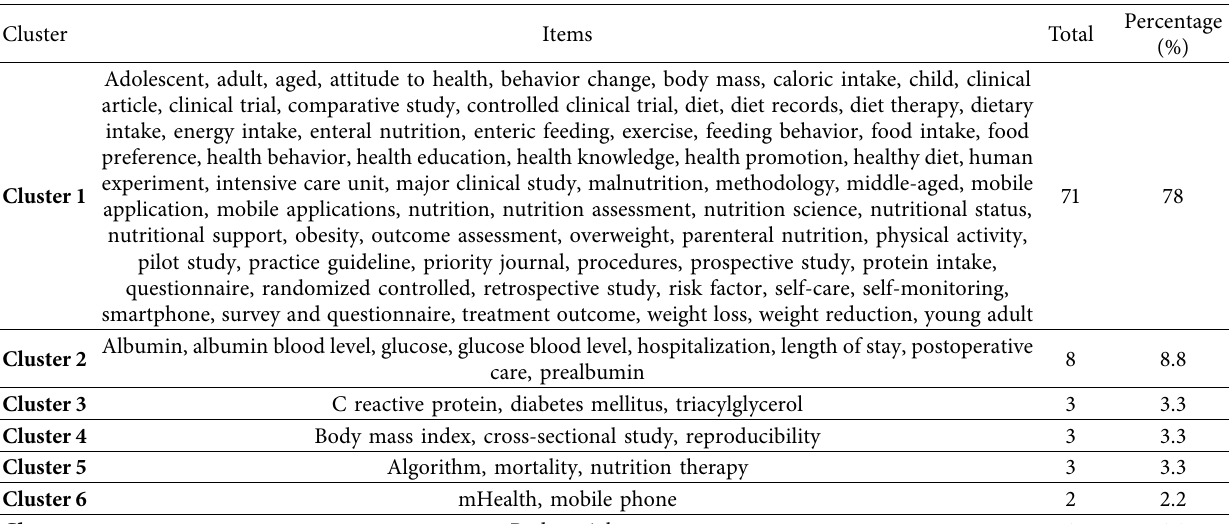
Table 1: The clusters of keyword